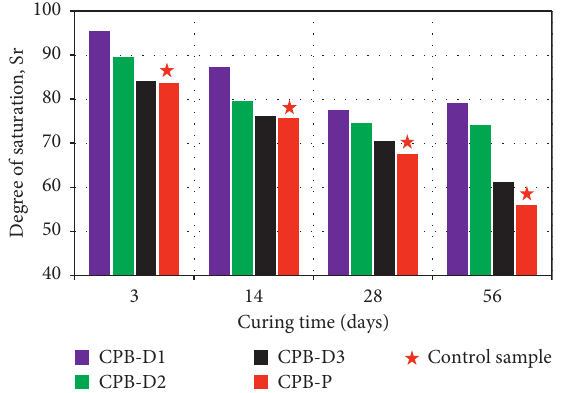
Figure 9: Change in the degree of saturation with time for diverse mine